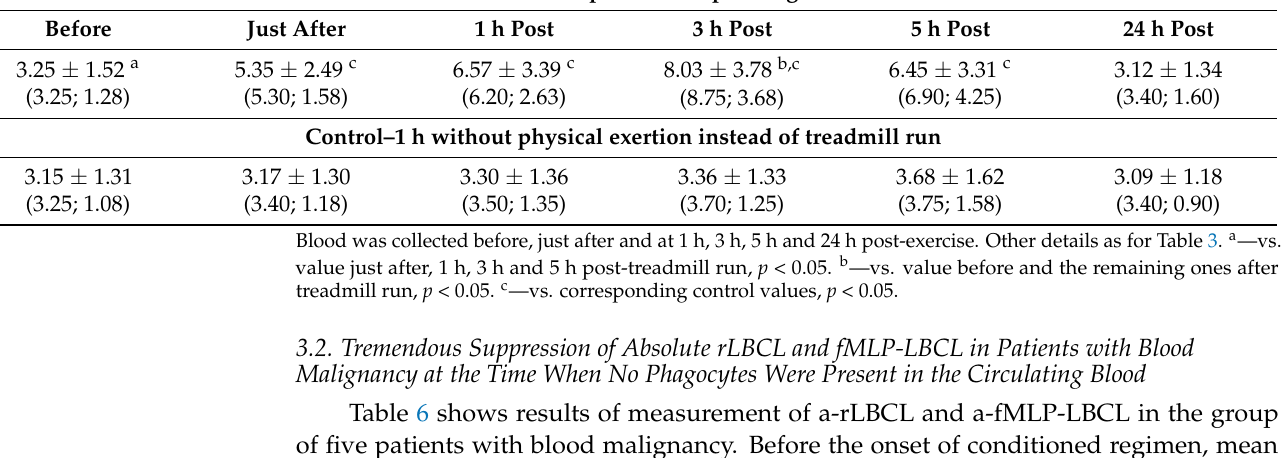
Table 5. Changes in total number of phagocytes ( × 10 3 / µ L) in peripheral blood in response to exhaustive treadmill